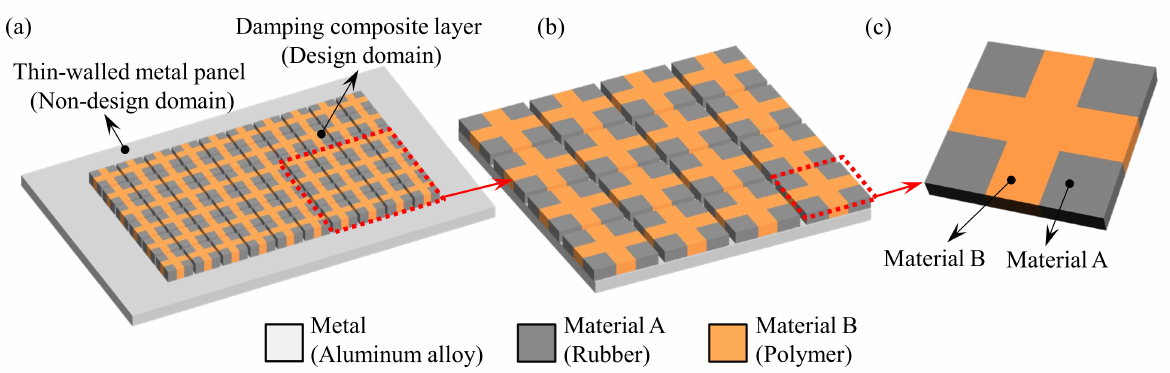
Figure 1. Two-scale composite plate design. ( a ) A composite plate consists of a metal panel and periodic damping composite. ( b ) Periodic damping composite. ( c ) Microstructure of the periodic damping